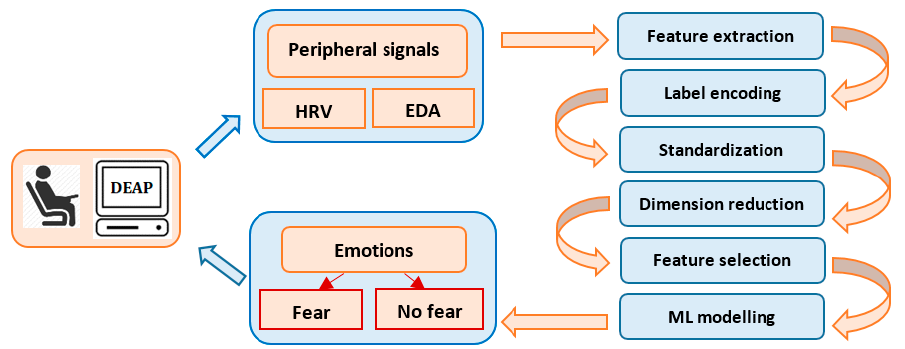
Figure 1. Data processing